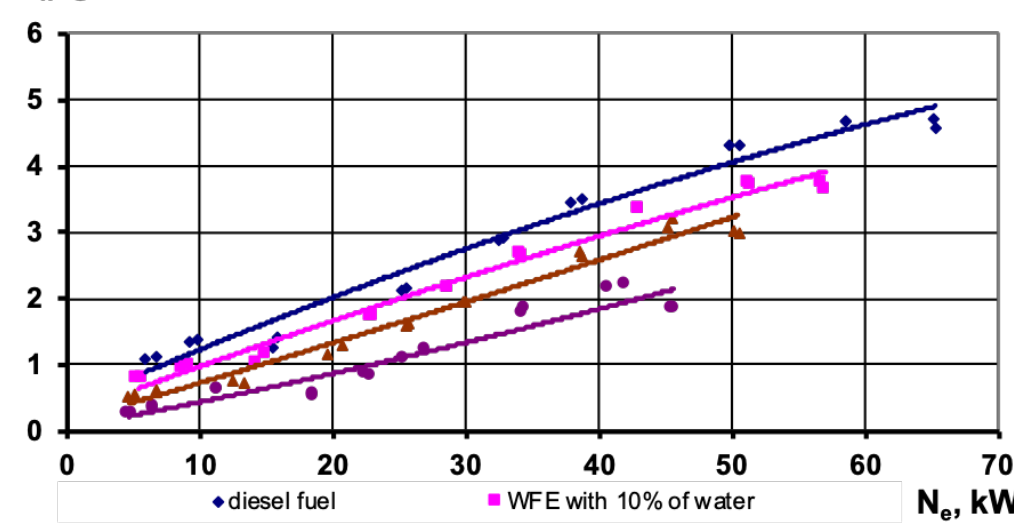
Figure 5. Concentration of nitrogen oxides (NOx) in the exhaust gases at the load characteristic of the